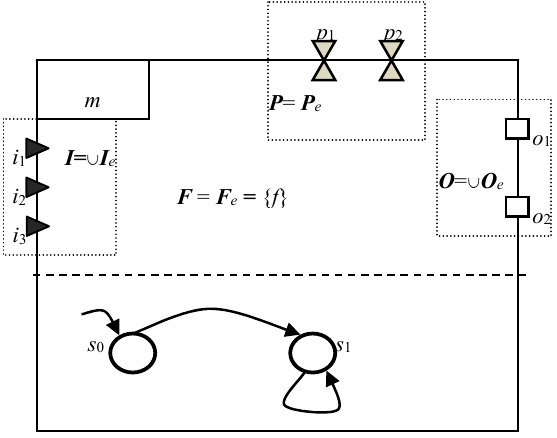
Figure 4. The diagram definition of the basic model.